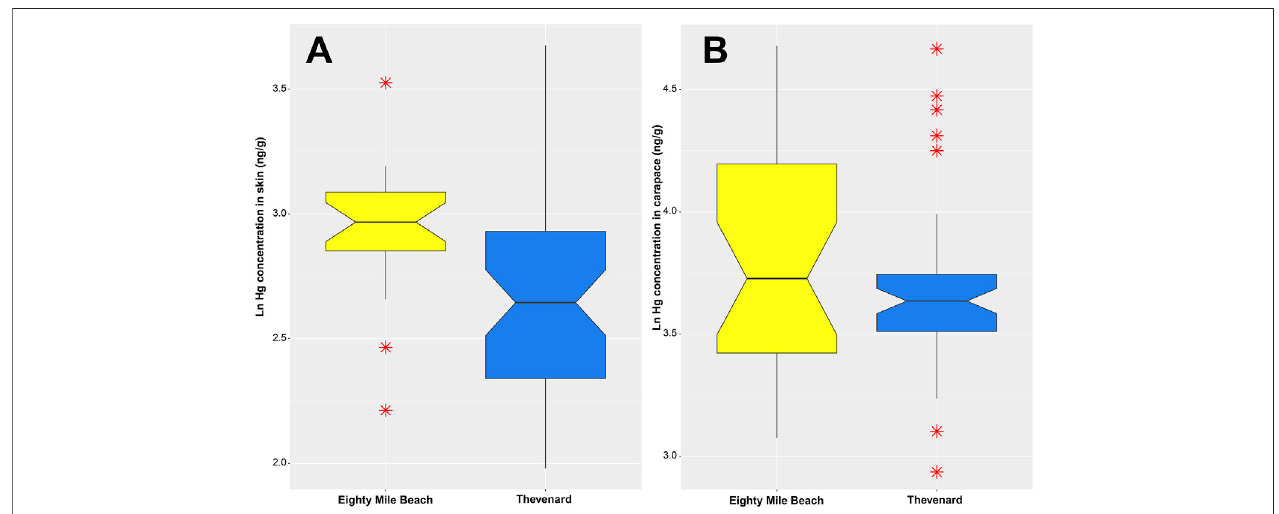
FIGURE 3 | Boxplot showing natural log(Ln) of Hg concentrations (ng/g) in (A) skin of turtles and (B) carapace of turtles, from Eighty Mile Beach and Thevenard Island, WA.